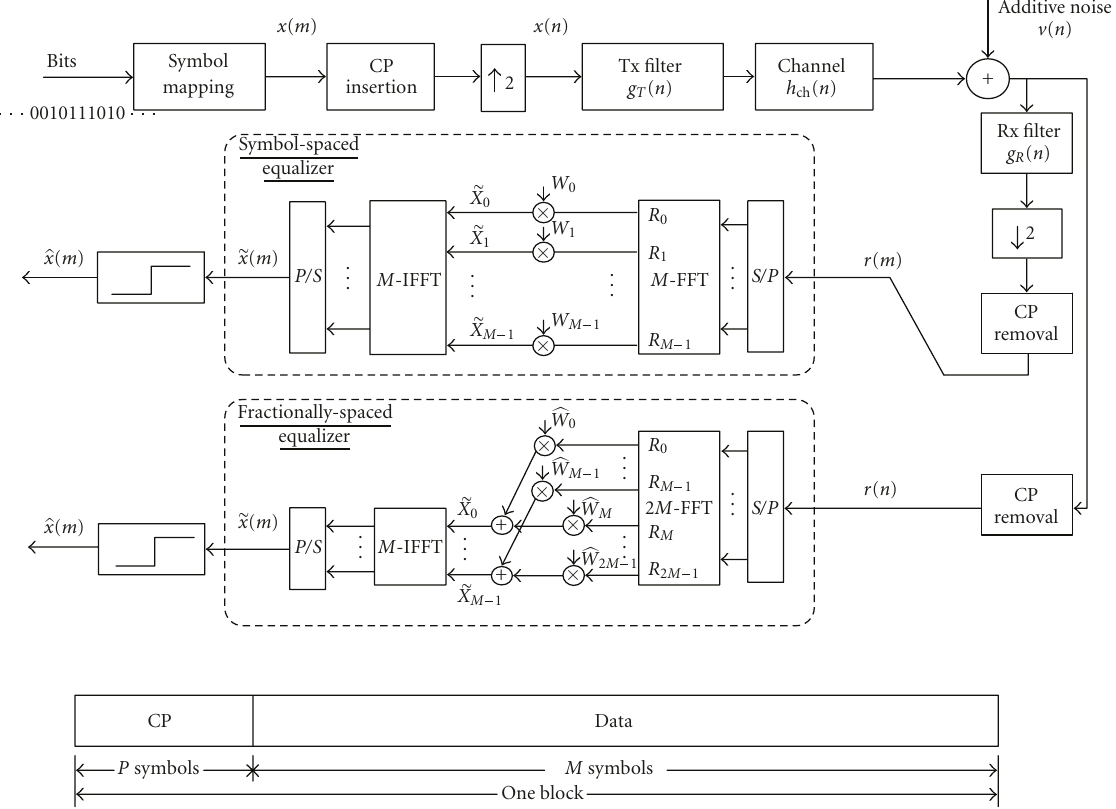
Figure 1: General model of FFT-SSE and FFT-FSE for single-carrier frequency-domain